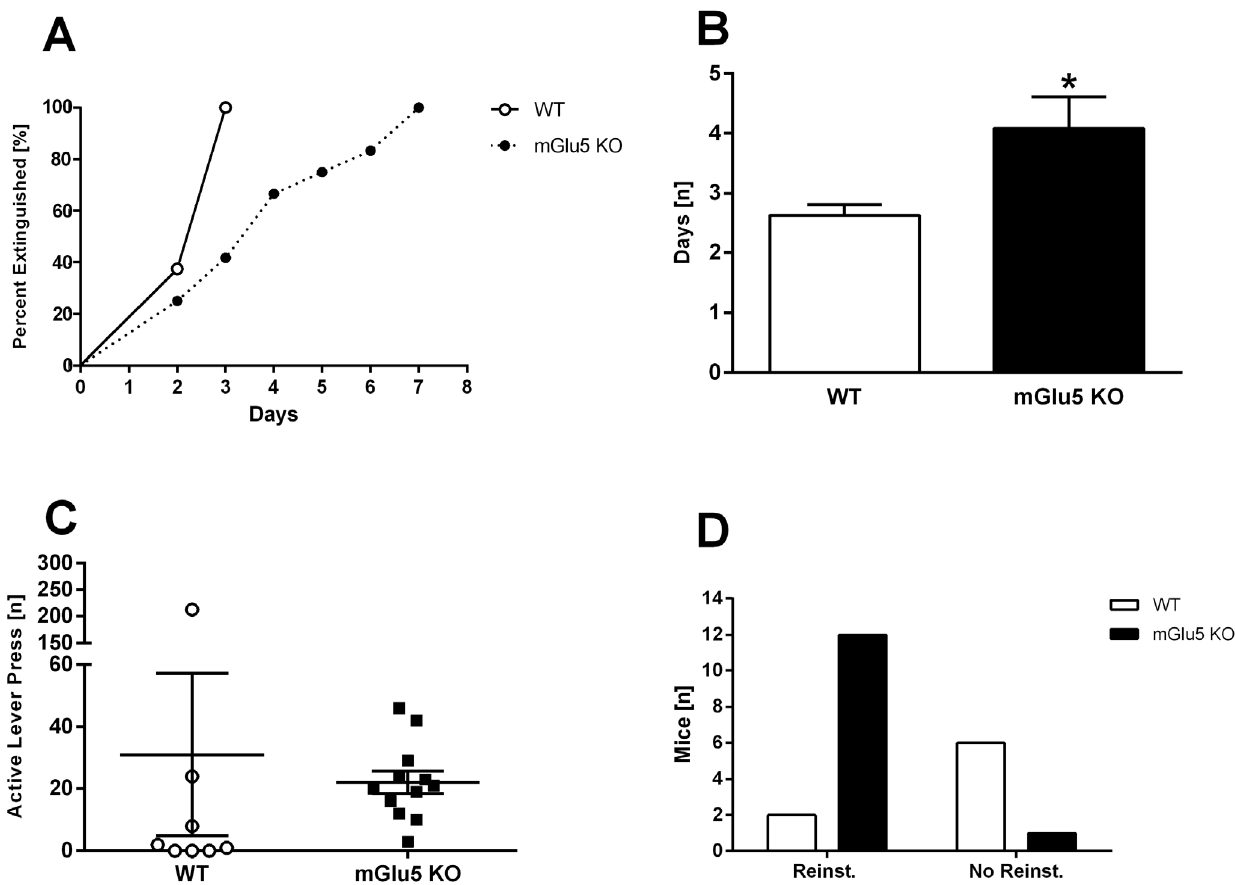
Figure 3. Extinction and reinstatement of the operant response for METH. A) Percentage of mice extinguished per day. mGlu5 KO mice took a significantly greater number of days to extinguish the operant response. Data (mean 6 SEM) analysed using a log-rank test; there was a significant effect of ‘genotype’ ( p =.03). B) Average number of days to extinguish the operant response. mGlu5 KO mice took significantly longer to extinguish their operant responding than WTs. Data (mean 6 SEM) analysed using one-way ANOVA; a significant effect of ‘genotype’ indicated by ‘*’ (* p , .05). C) Active lever pressing during reinstatement. Data (mean 6 SEM) analysed using one-way ANOVA. D) Proportion of WT and mGlu5 KO mice meeting reinstatement criteria. Data analysed using a Fisher’s exact test. Abbreviations: Reinst - mice which met reinstatement criteria; No Reinst - mice which did not meet reinstatement criteria.